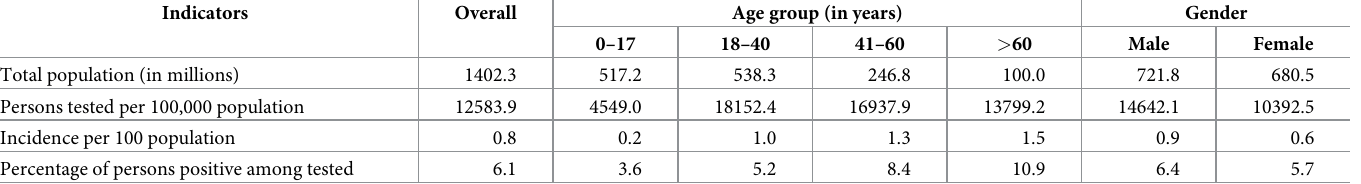
Table 1. COVID-19 testing, incidence and positivity by gender and age among tested individuals, India (March 2020 to January 2021).